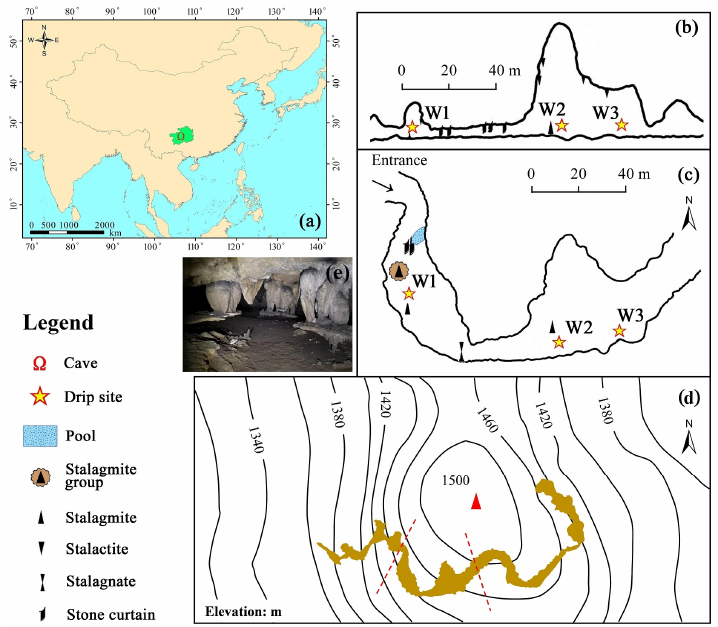
Figure 1. The selected drip sites in the Shijiangjun Cave ( a ): location of the Shijiangjun Cave in China; ( b ): longitudinal profile of cave sampling section; ( c ): planar graph of the sampling section in cave passage; ( d ): topographic map of the surrounding area, the dark-yellow region represents the planar graph of the Shijiangjun Cave, and the red dotted lines represent the cave sampling section; ( e ): speleothems and sediments in the Shijiangjun